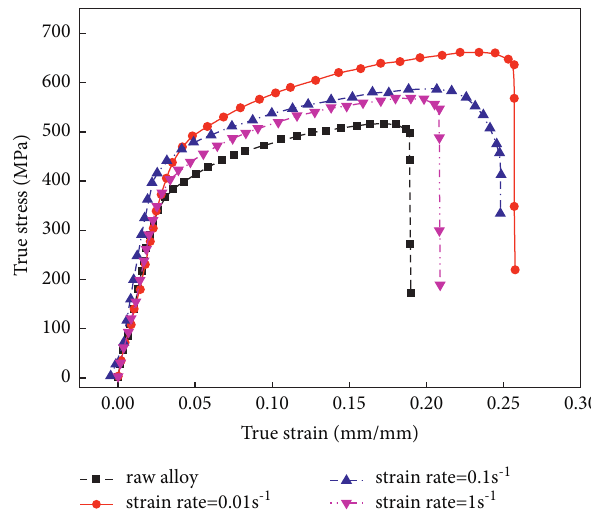
Figure 8: True stress-strain curve of standard tensile 7050 aluminium alloy samples.